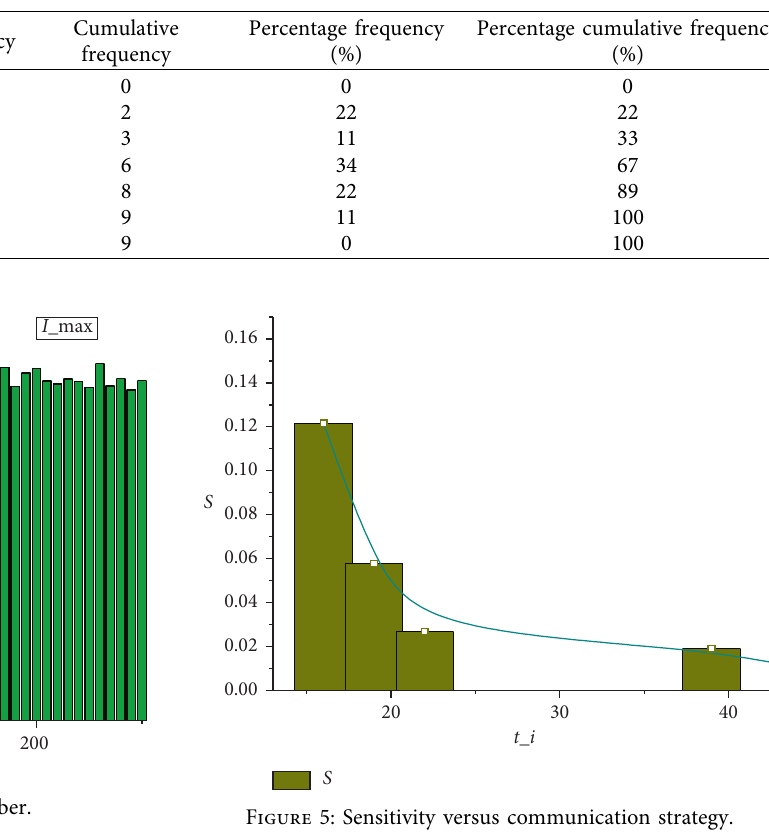
Table 4: Time distribution of material provided by vendors.